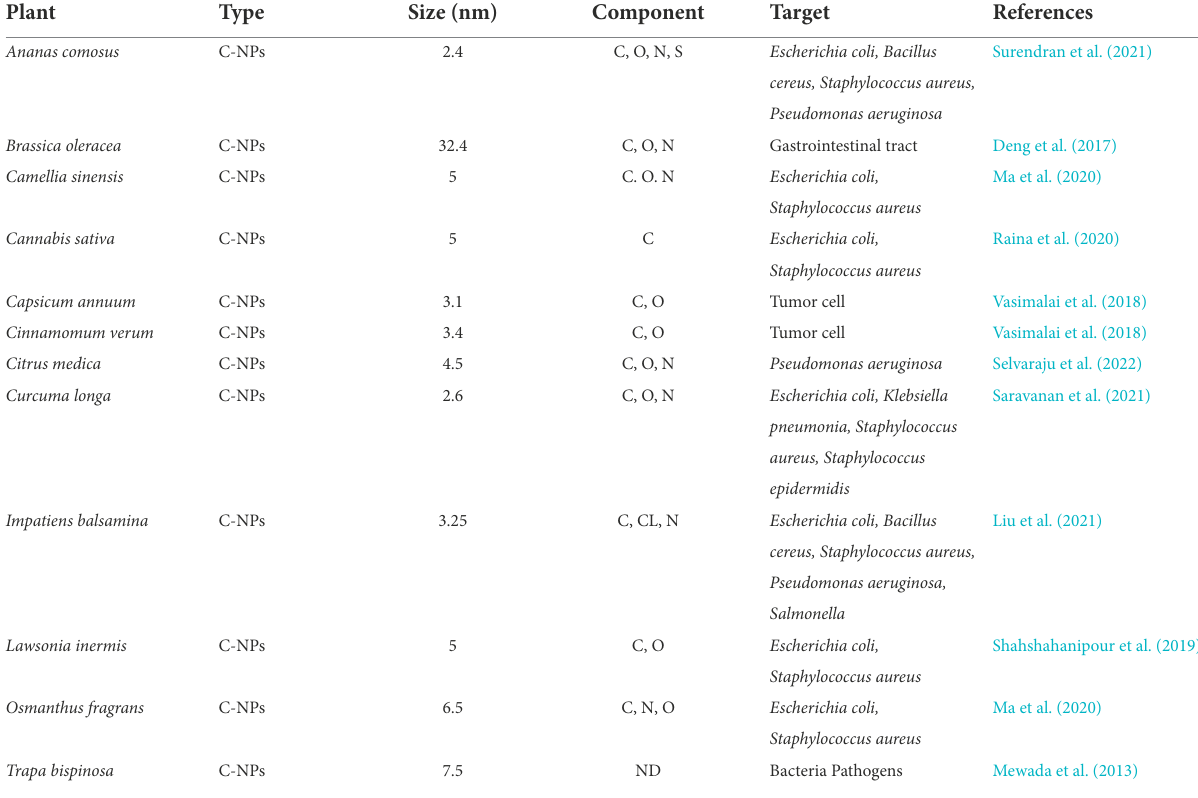
TABLE 3 Examples of metal-free plant derived nanoparticles.